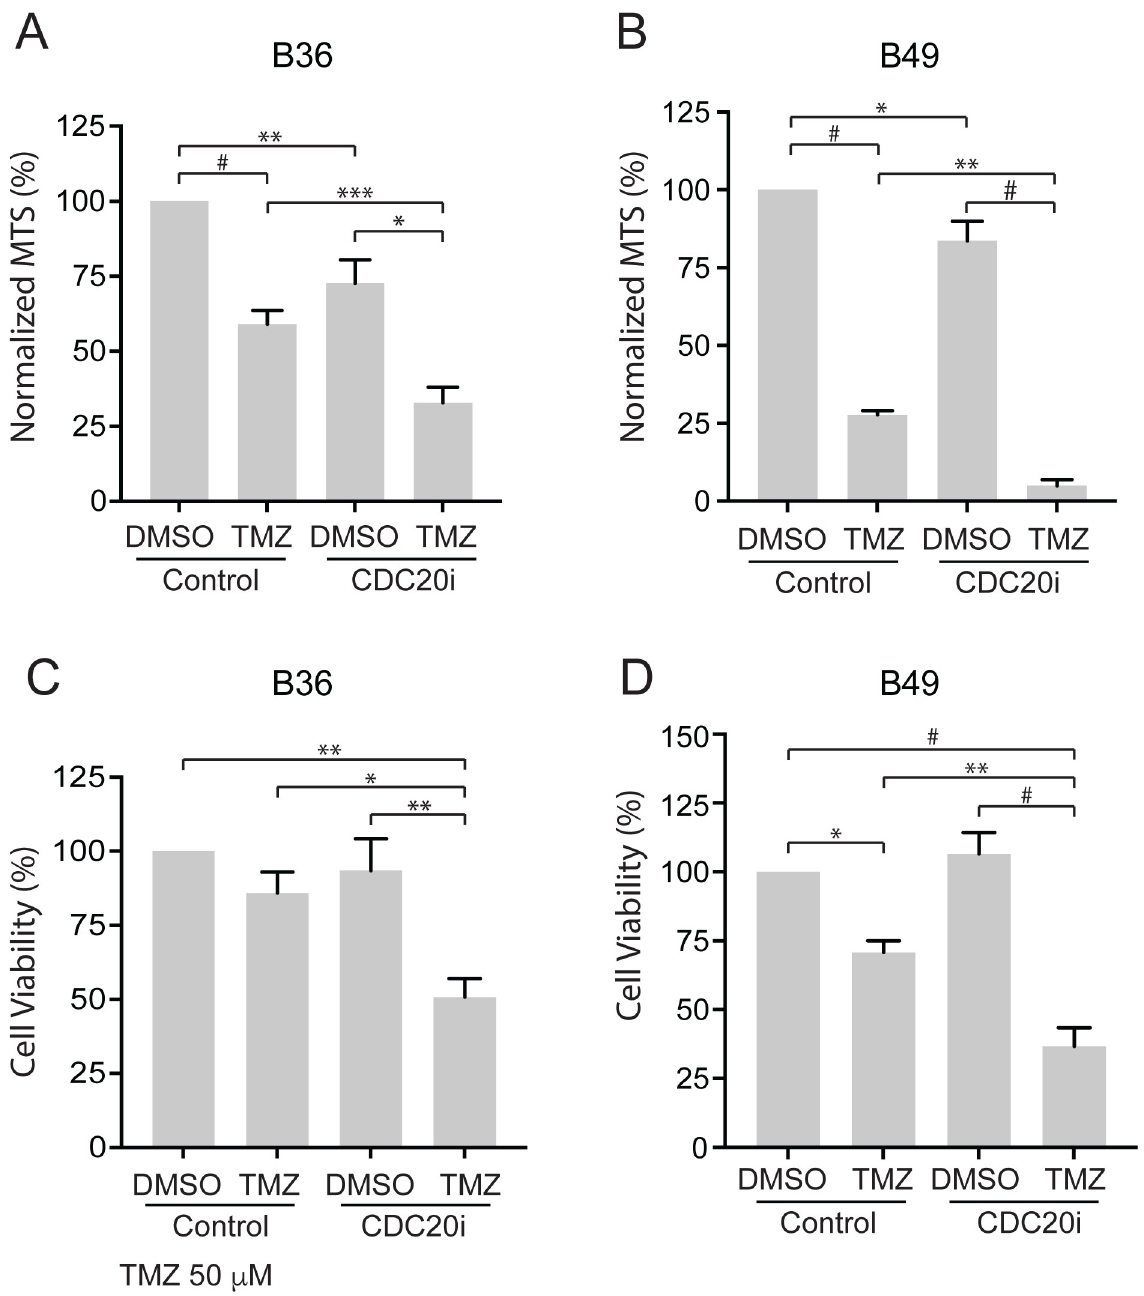
Fig 1. CDC20 inhibition increases sensitivity to TMZ in adherent and neurospheres GSCs. (A) Adherent B36 GSCs were transduced with CDC20 RNAi or control SH002 RNAi and selected with puromycin. Seven days after transduction, GSCs were treated with 50 μ M TMZ or vehicle for 10 days. Cell proliferation was then assessed by MTS assay. Data represent mean +/- SEM (n = 7, ANOVA). (B) Adherent B49 GSCs were treated as in (A). Data represent mean +/- SEM (n = 4, ANOVA). (C and D) B36 (C) and B49 (D) GSCs were transduced, passaged to sphere culture format, and treated as in A. 10 days later, cell viability was assessed by luminescent ATP assay. Data represent mean +/- SEM (n = 5, ANOVA). � P < 0.05, �� P < 0.01, ��� P < 0.001, # P <